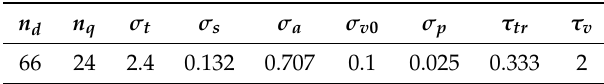
Table 1. Parameter